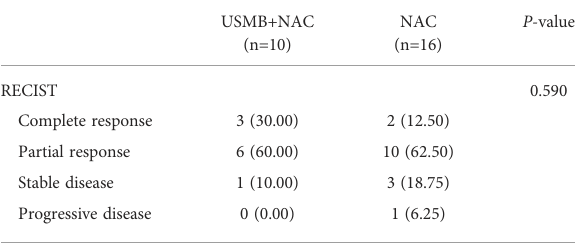
TABLE 2 Comparison of the response evaluation criteria in solid tumors between USMB+NAC and NAC groups.